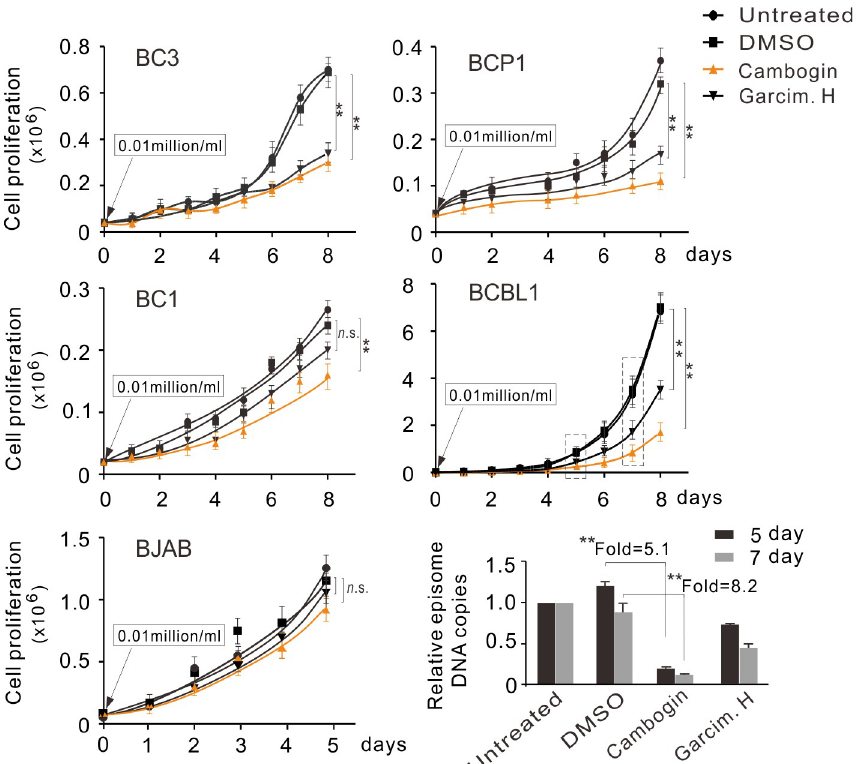
Fig 6. Cambogin dramatically inhibits the proliferation of KSHV-infected cells. Equal amounts of KSHV-positive PEL and KSHV negative BJAB cells were untreated or individually treated with 500 nM Cambogin or Garcimultiflorone H for the indicated time, and then subjected to quantitation of total live cell amount. DMSO was used as a control. The KSHV episome copy number relative to the untreated group at day 5 and 7 in BCBL1 cells was measured and is shown. �� p < 0.01; n . s ., no